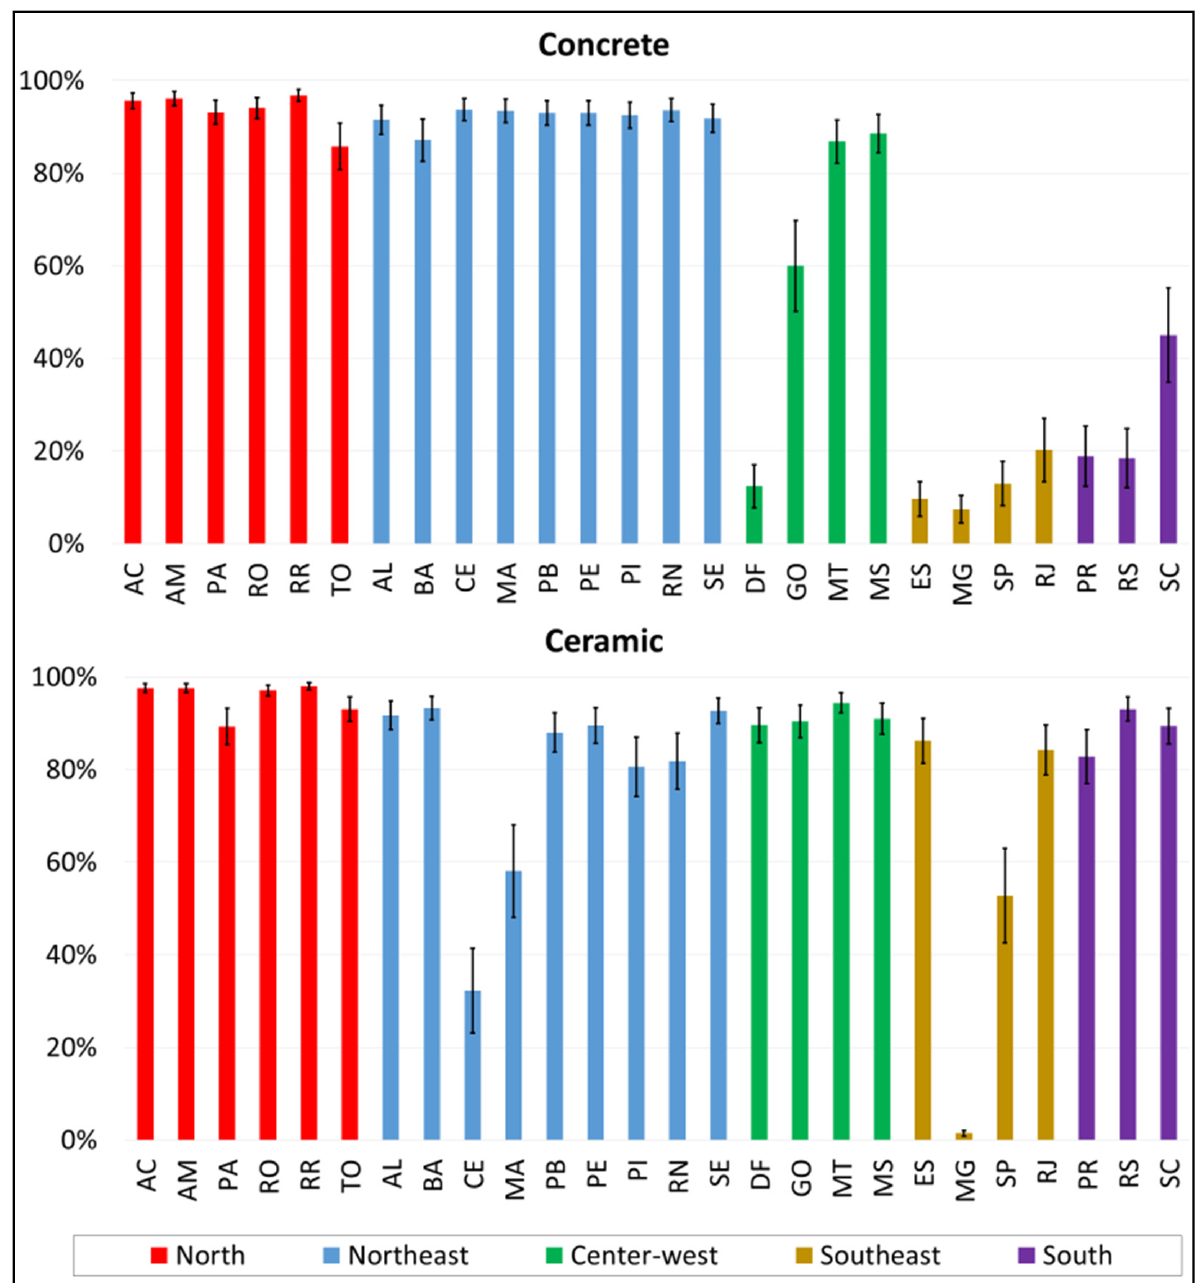
Figure 10. Percentage of the transportation stage in the Ecosystem Quality impact. The error bars represent the standard deviation due to transportation scenarios.